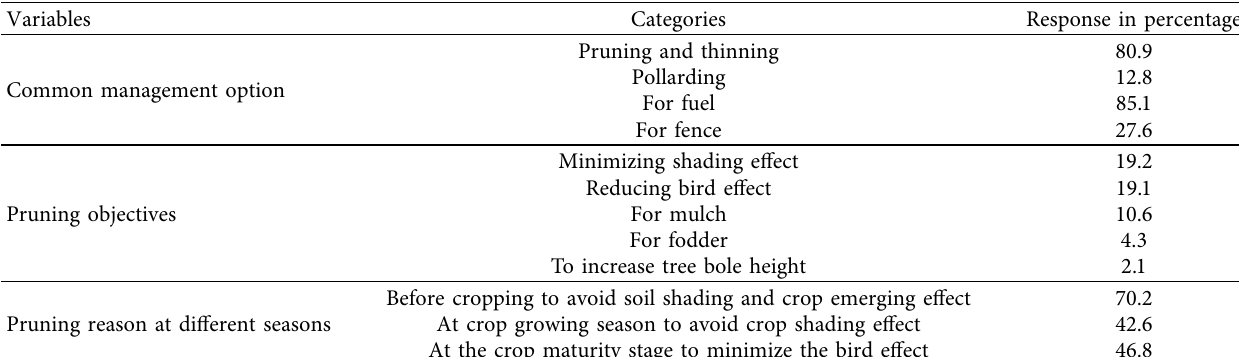
Table 11: Main objectives and preferred season for pruning management of Acacia seyal